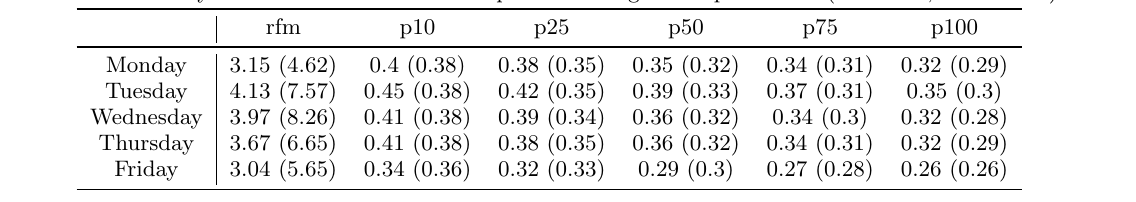
Table 7: Per day of the week metrics for setup with the highest improvement (wCD=50,wCWD=50)